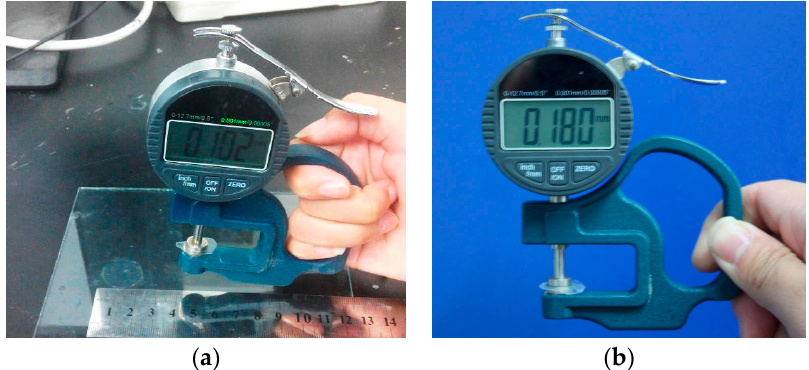
Figure 1. Digital photos of CaAlg membrane ( a ) and MIP membrane ( b ).